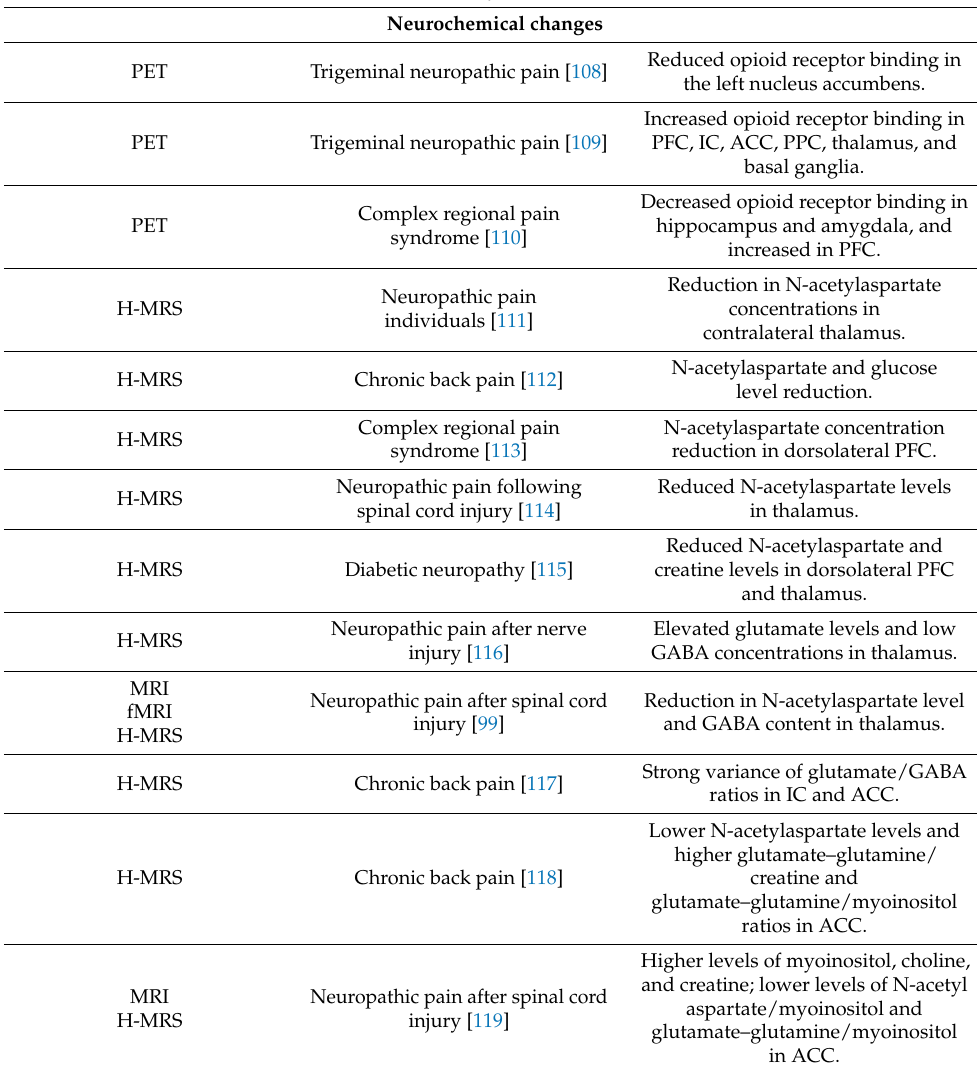
Table 1. Cont. Structural Changes in Gray Matter Volume, Cortical Thickness, Integrity and Connectivity of White Matter Neurochemical